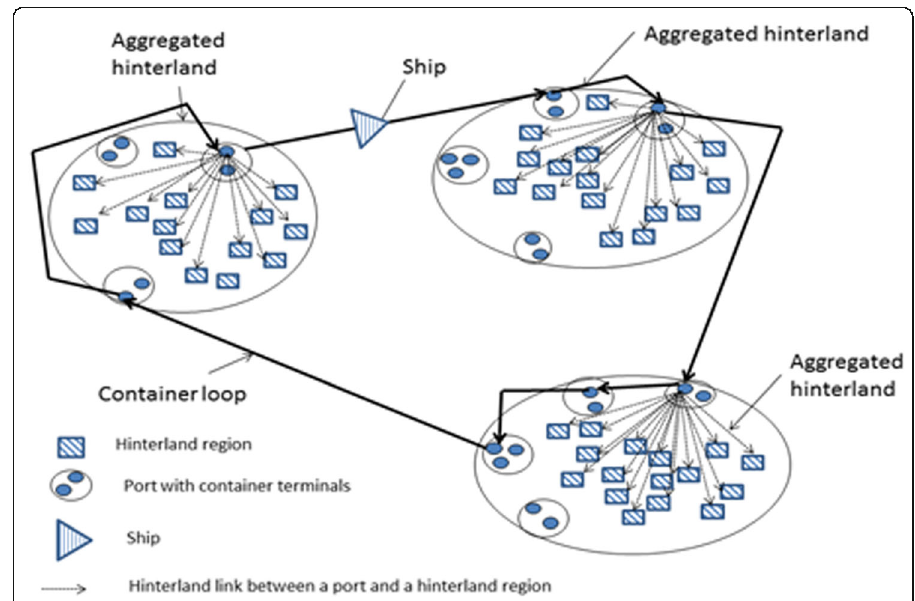
Fig. 2 Conceptual representation of the Chain Cost Model. Source: based on van Hassel et al., (van Hassel et al. 2016a,